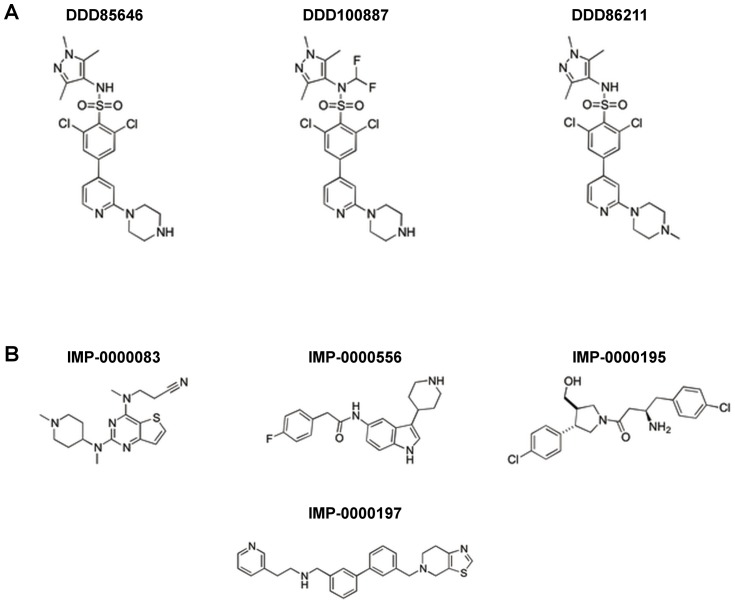
Chemical structures of NMT inhibitors.(A) Resynthesised T. brucei inhibitors identified by the Dundee Drug Discovery Unit as also inhibiting L. major NMT [31], [37]. Results summarized in Table 2. (B) Selective inhibitors identified by high throughput screening against L. donovani NMT [35]. Results summarised in Table 3.